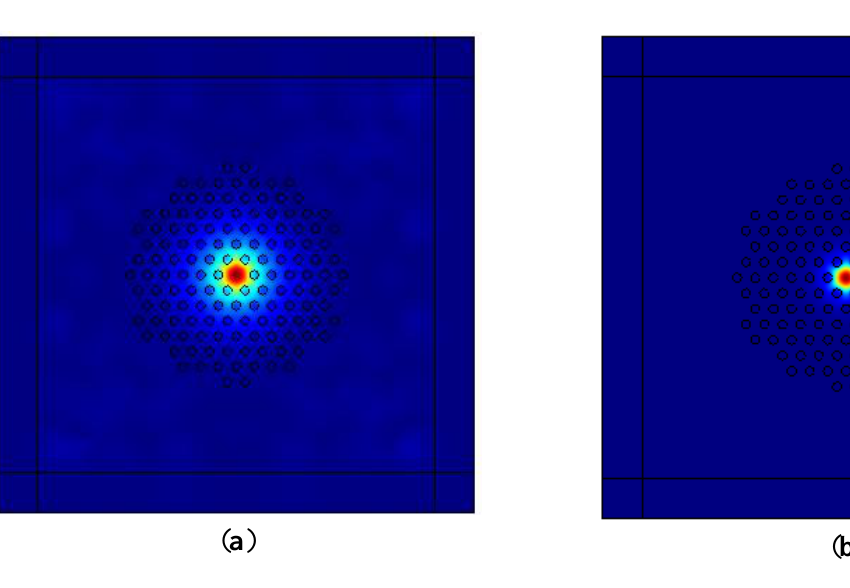
Figure 2. The simulated distributions of LMA-8 PCF fundamental modes with the volume ratio of chloroform and ethanol as 9:1, ( a ) at 0 °C, ( b ) at 20